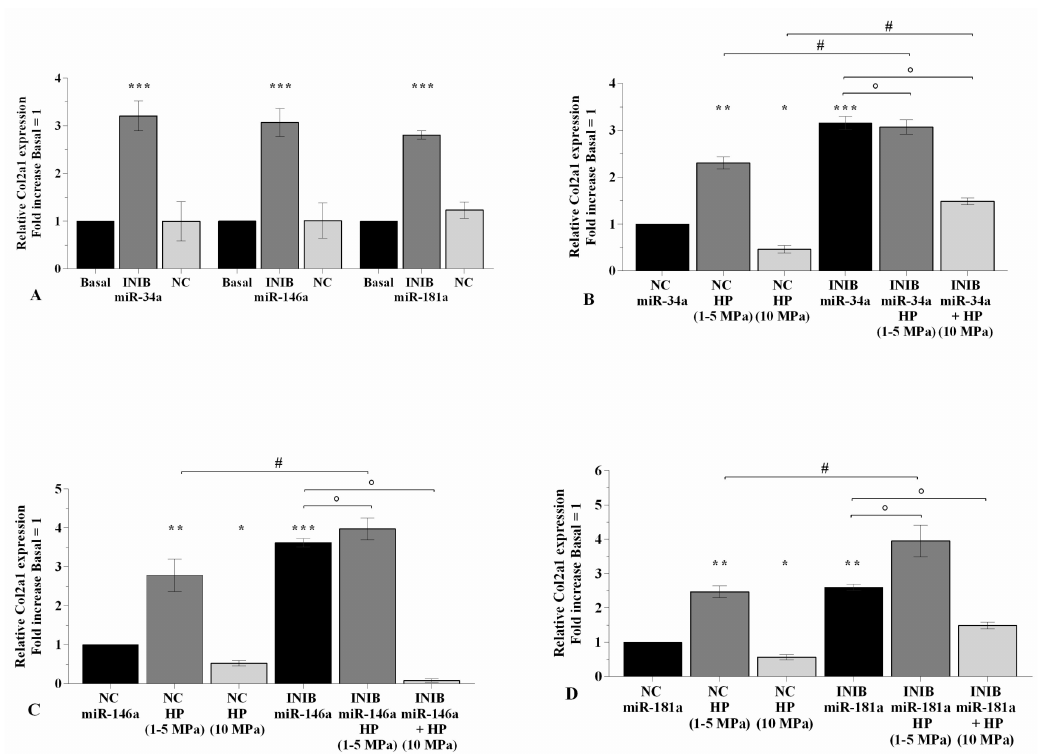
Figure 4. miRNA inhibition induces the expression of Col2a1 altered by HP. ( A – D ) Expression levels of Col2a1 analyzed by real-time PCR. Human OA chondrocytes were evaluated at basal condition, after 24 h of transfection with miR-34a, miR-146a, and miR-181a inhibitors (50 nM) or NC (5 nM), and after 3 h of low sinusoidal (1–5 MPa) or static continuous (10 MPa) HP exposure. The gene expression was referenced to the ratio of the value of interest and the value of basal condition or NC, reported equal to 1. Data were expressed as mean ± SD of triplicate values. * p < 0.05, ** p < 0.01, *** p < 0.001 versus basal condition or NC. ◦ p < 0.05 versus inhibitor. # p < 0.05 versus HP. INIB = Inhibitor, NC = negative control